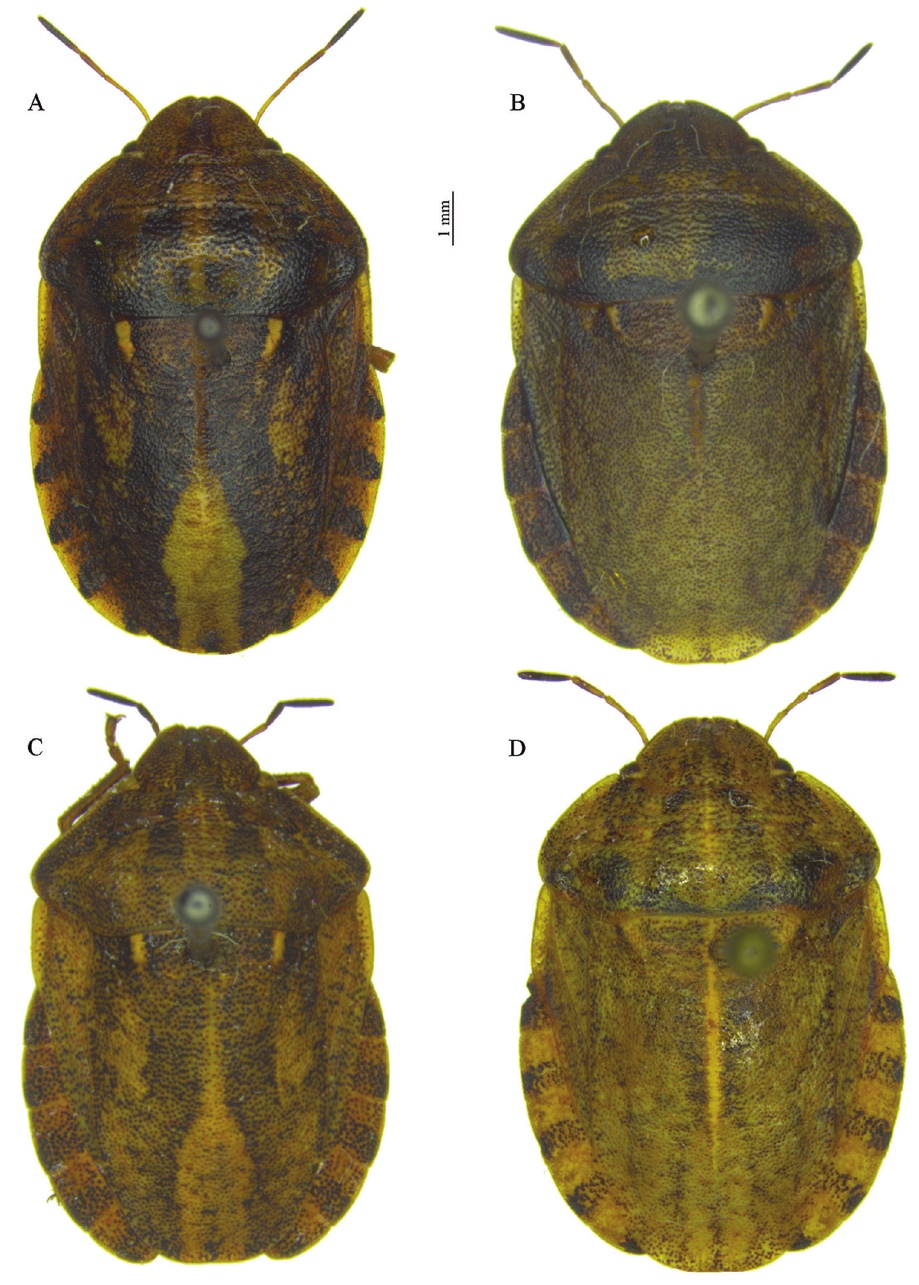
Figure 5. Species of the genus Eurygaster Laporte, general view: A E. integriceps (Puton) B E. maura L. C E. testudinaria (Geoffroy) D E. dilaticollis Dohrn. Specimens A–C were collected in the Voronezh Region; specimen D was from the Teberda Nature Reserve,